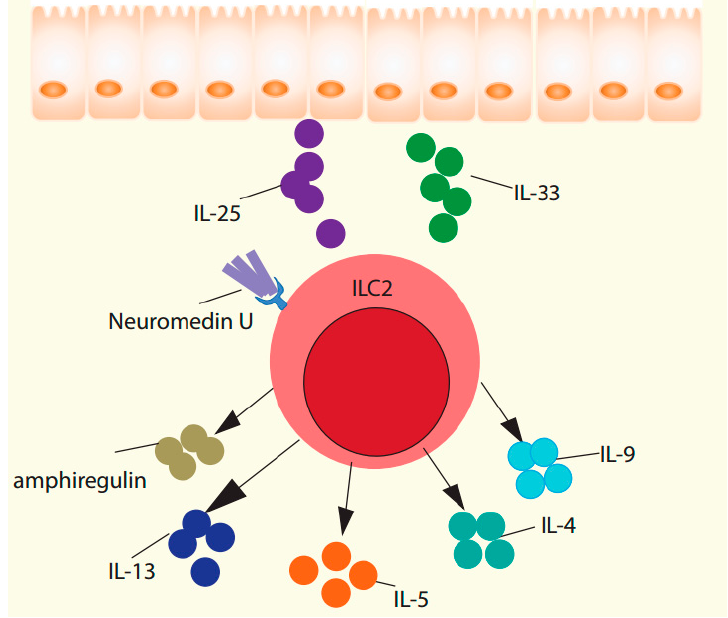
Figure 1. Biological importance of ILC2 in helminth immunity.